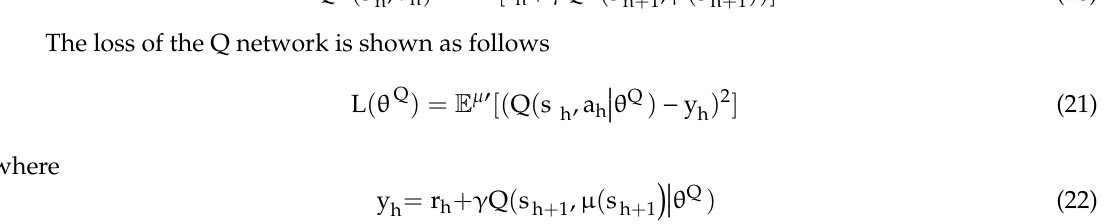
Figure 4. Network structure of DDPG algorithm.